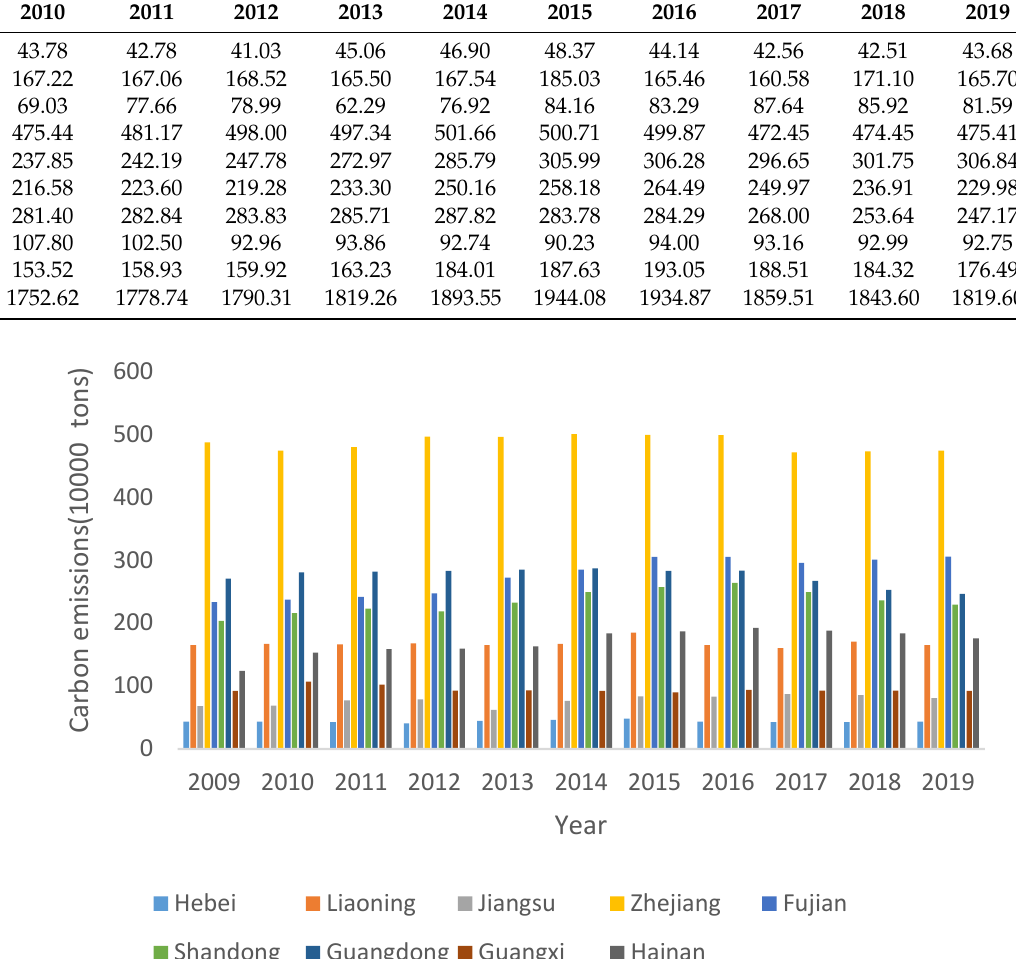
Table 5. Carbon emissions from marine fisheries in nine coastal provinces from 2009 to 2019 year (10,000 tons).